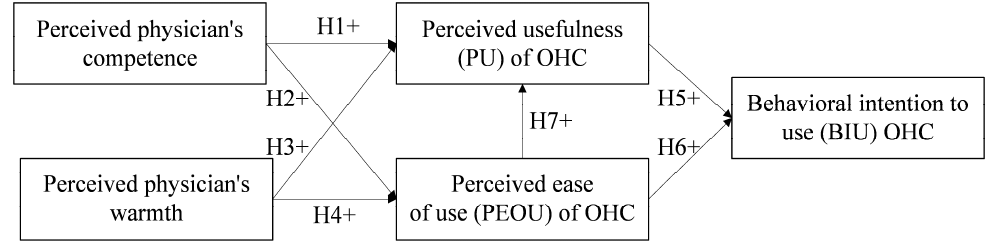
Figure 1. Research model. H1+, H2+, H3+, H4+, H5+, H6+, H7+ represent positive hypotheses.